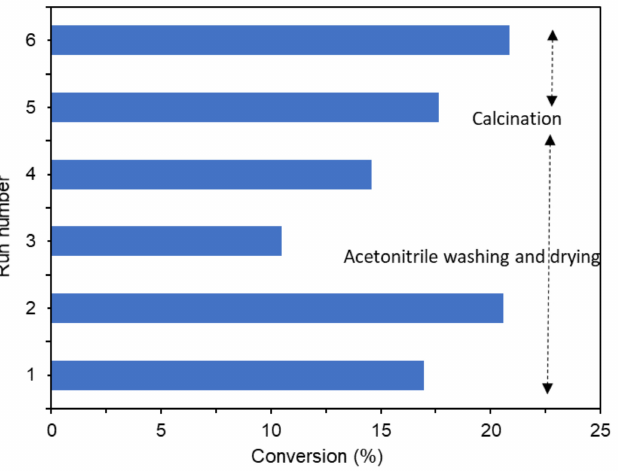
Figure 25. Recycling 3DOm-I Ti-beta catalyst for the epoxidation of cyclooctane